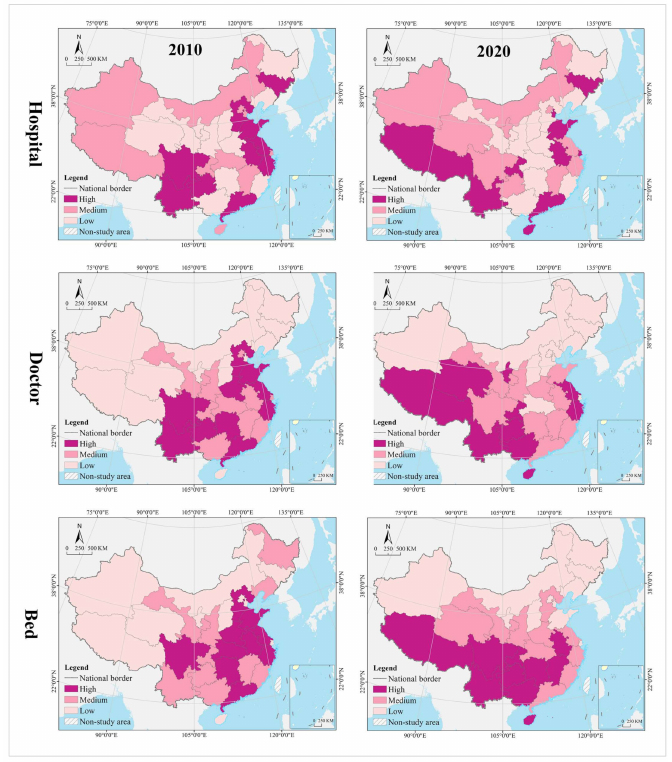
Figure 5. Distribution pattern of medical resources